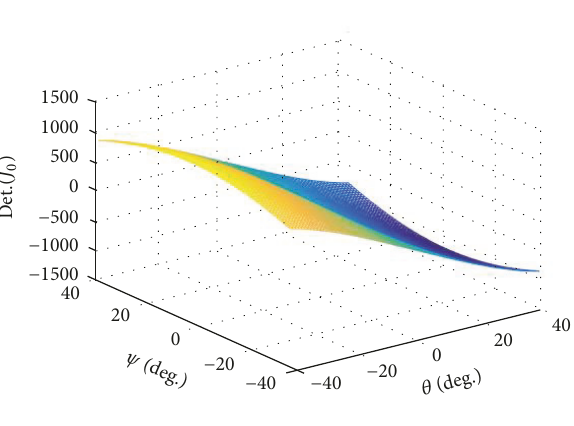
Figure 6: The overall Jacobian diagram of the